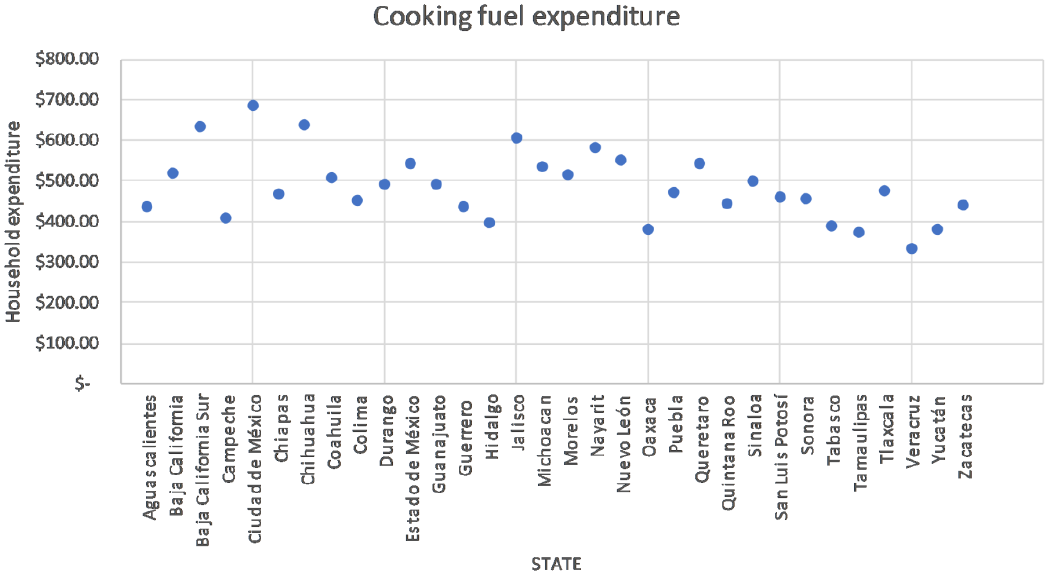
Figure 2. Average bimonthly electricity expenditure per household in pesos, by State. In Mexico, payment for domestic electric service is made every two months. Source ENCEVI, INEGI.